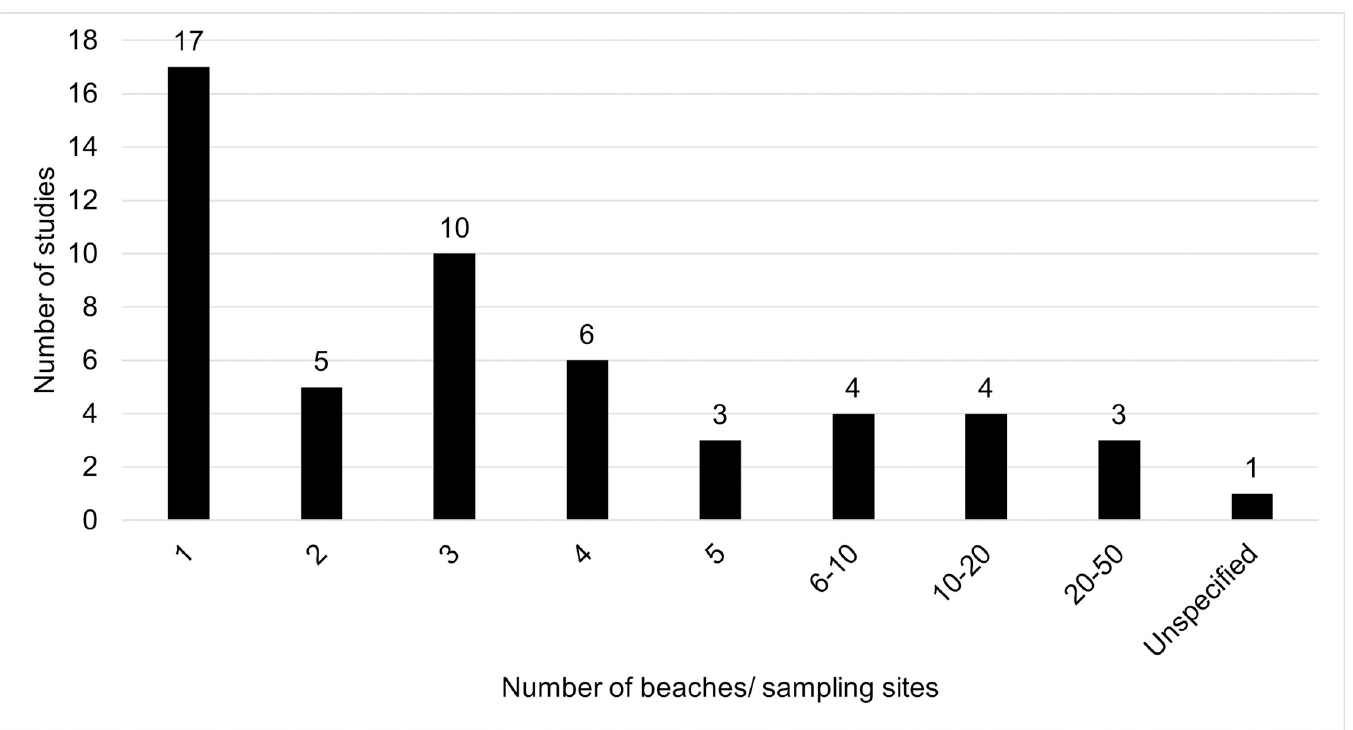
Fig 5. Frequency of the number of beaches, or sampling sites if beaches not provided.